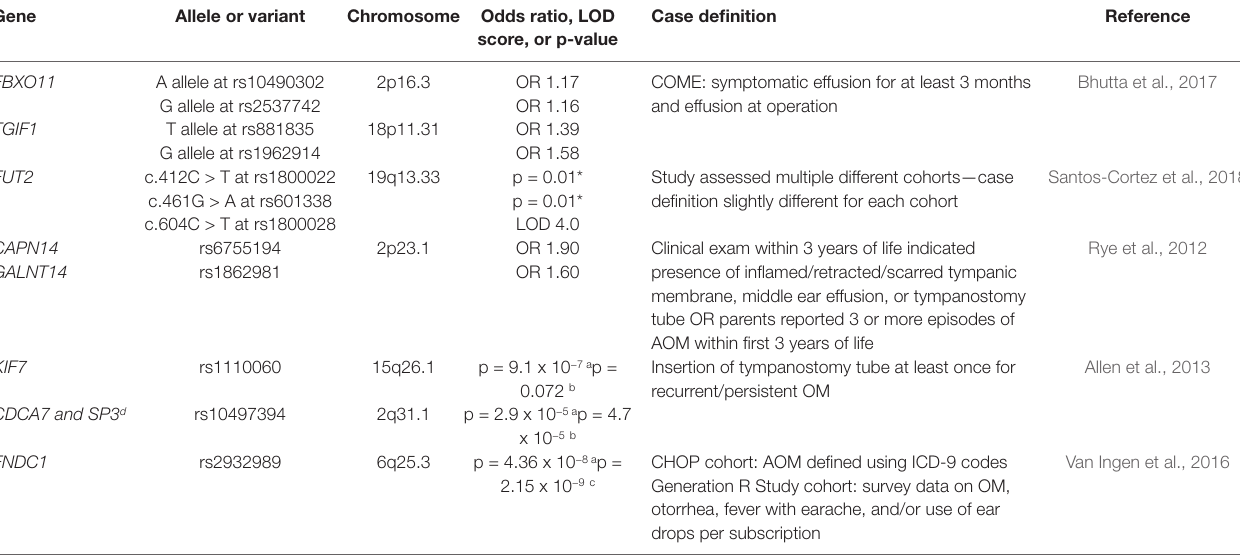
TABLe 3 | List of genes implicated in otitis media from genomic association studies. Gene Allele or